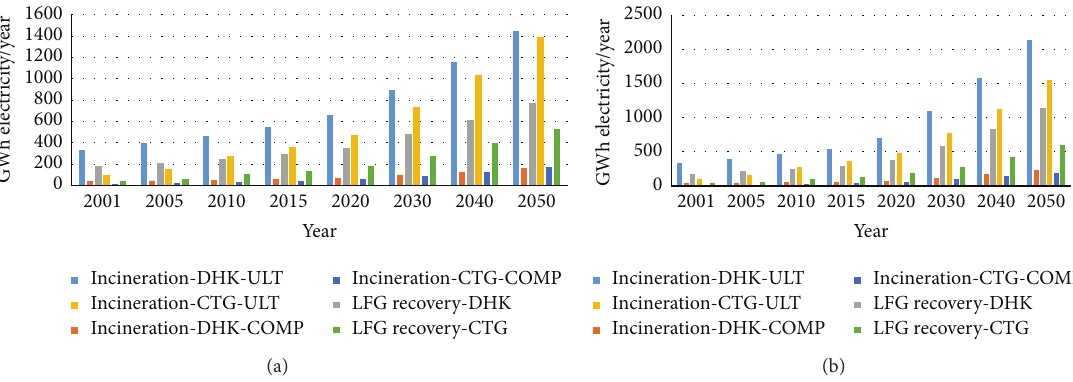
Figure 6: WtE assessments in terms of electricity generation potential (actual and projected) for Dhaka and Chittagong city from year 2001 to year 2050. (a) represents the projection using historical MSW generation rate and (b) represents the projection using CAGR approach. The legends of the figure are given at the bottom of (a) and